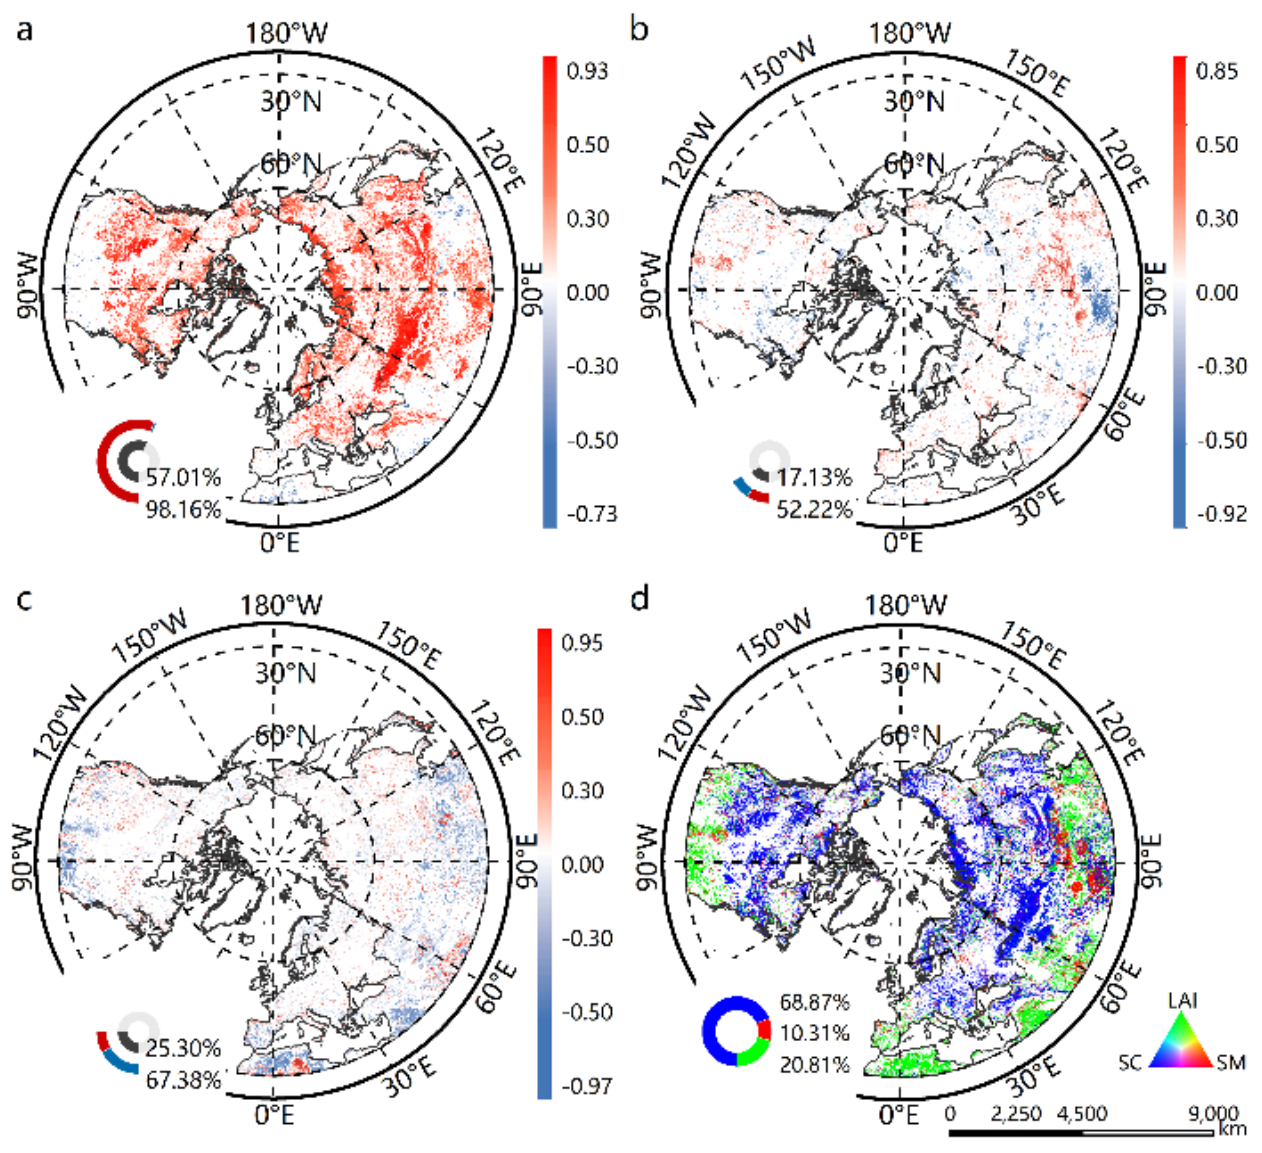
Figure 5. Spatial distributions of the partial correlation coefficients between blue-sky albedo and SC (a), SM (b) and LAI (c), the spatial distribution of RGB synthesis with three partial correlation coefficients (d). Nonsignificant pixels were excluded. Insets at the bottom left in (a), (b) and (c) show the percentages of pixels with significant correlation (dark gray), significant positive correlation (red) and significant negative correlation (blue), respectively. Insets at the bottom left in (d) show the percentages of pixels dominated by each factor, with bar color corresponding to the color in the map.